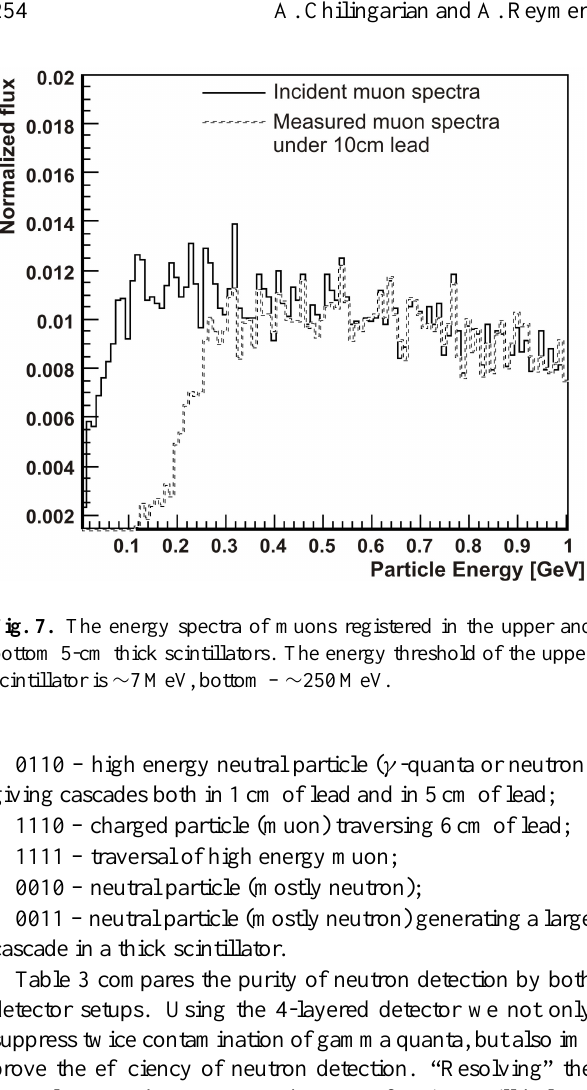
Fig. 9. Spectra of Primary Protons initiated counts in different lay- ers of the SEVAN